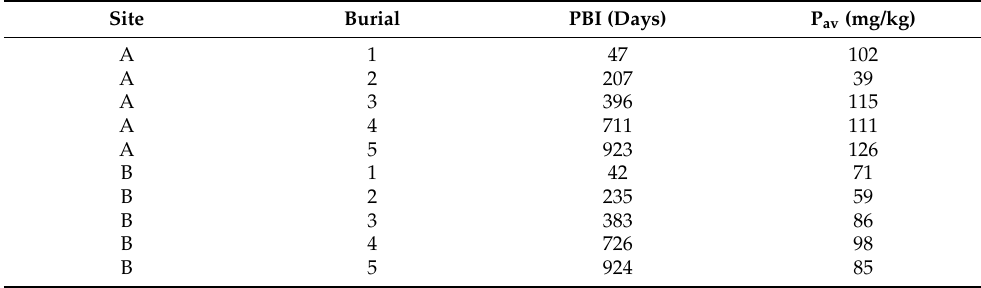
Table 2. Summary of the bioavailable P (P av ) concentration found in each sample site at different Post-Burial Intervals (PBIs), obtained using the Olsen P method application. The soil samples have been collected below each carcass, approximately between 100 and 125 cm